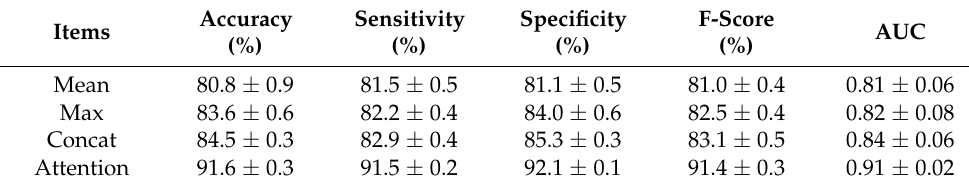
Table 5. Ablation study on branch selection attention module.